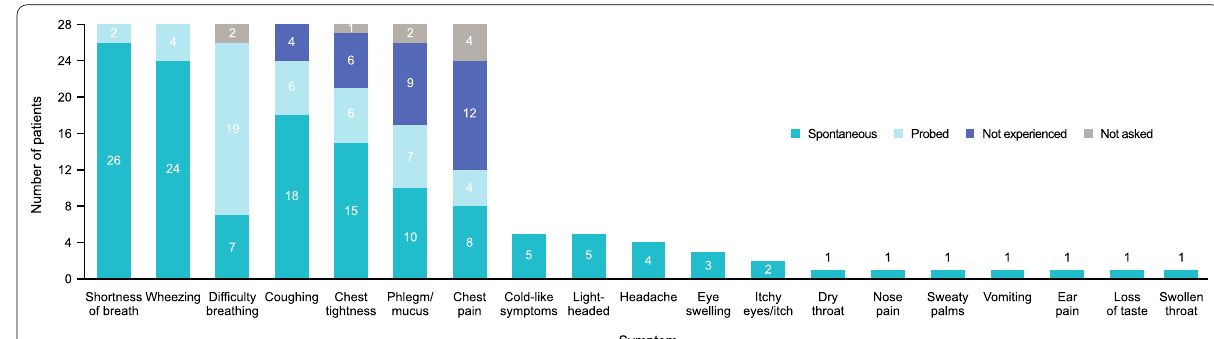
Fig. 1 Symptoms of moderate asthma exacerbations. Note : Shortness of breath, wheezing, difficulty breathing, coughing, chest tightness, phlegm/ mucus, and chest pain were probed by the interviewer. All other symptoms were only reported spontaneously and because of that, corresponding columns are